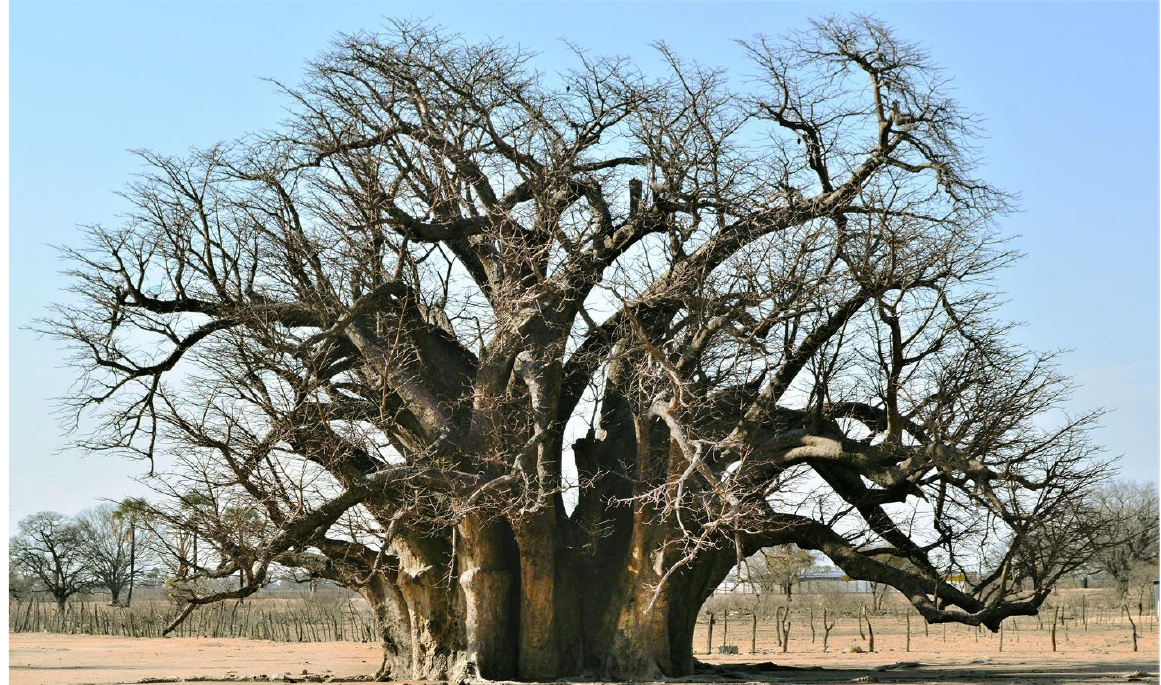
Figure 7. General view of the Amadhila baobab taken from the north-west, when the tree was still standing.